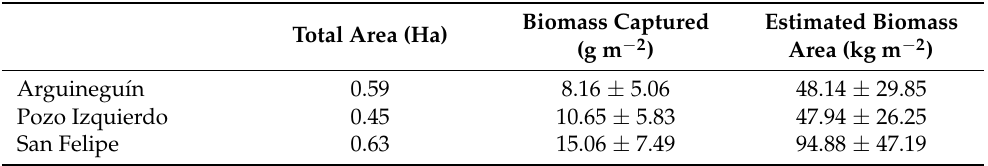
Figure 7. Mean catches per unit effort (CPUE), ( A ) CPUE, individuals per hour − 1 gatherer − 1 ; ( B ) CPUE, grams per hour − 1 gatherer − 1 recorded during 2020–2021 for Percnon gibbesi caught in three intertidal areas of Gran Canaria. Table 5. Mean biomass captured and mean total biomass estimated of Percnon gibbesi for the three studied intertidal